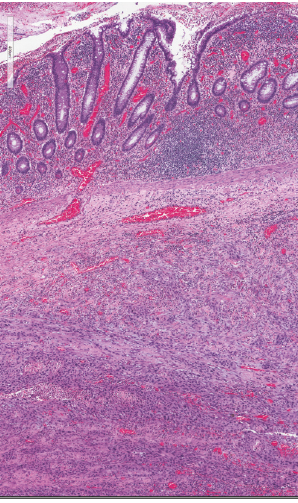
Figure 3: Microscopic